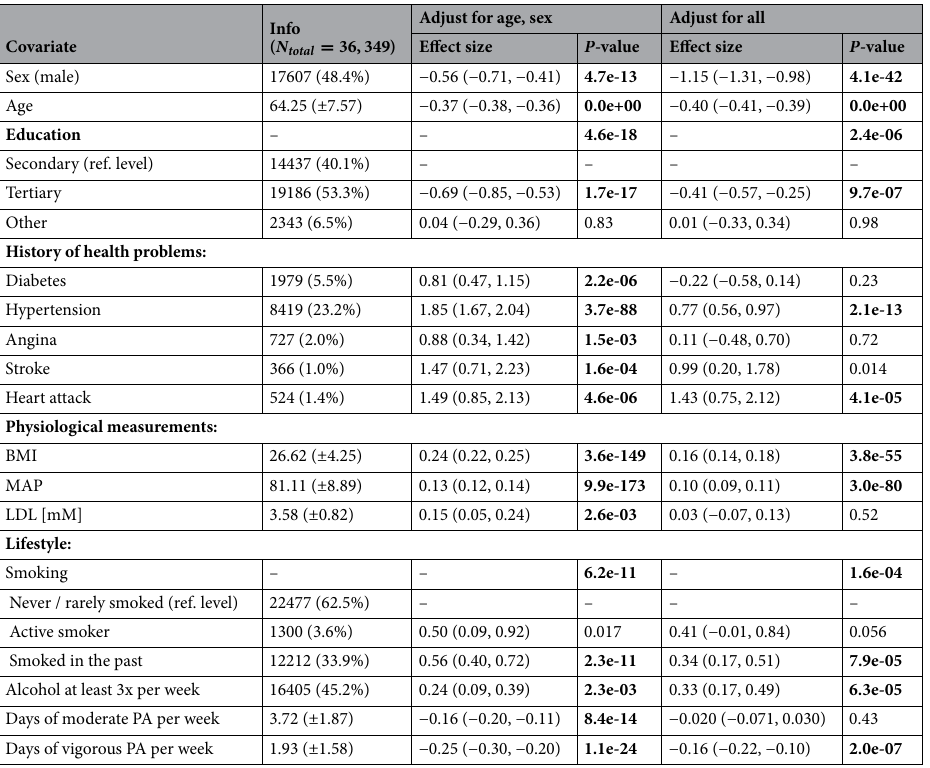
Table 1. Association of anthropometric features and cardiovascular risk factors in participants of the UKB with delta age. The “Info” column lists the number of corresponding participants for categorical features (with the percentage of the total population in parentheses) or the mean value for numerical features (with the standard deviation in parentheses). P -values and effect sizes in the left double-column are adjusted for age and sex (or only sex for the age-row and vice versa). In the right double-column, the adjustment also includes all other parameters listed in the table. In the “Effect size” columns, values in parentheses denote the lower and upper bounds of the 95% confidence interval. P -values smaller than the Bonferroni-corrected threshold ( 0.05 / 19 = 0.0026 ) are highlighted in bold. BMI, body mass index; MAP, mean arterial pressure; LDL, low- density lipoprotein; PA, physical